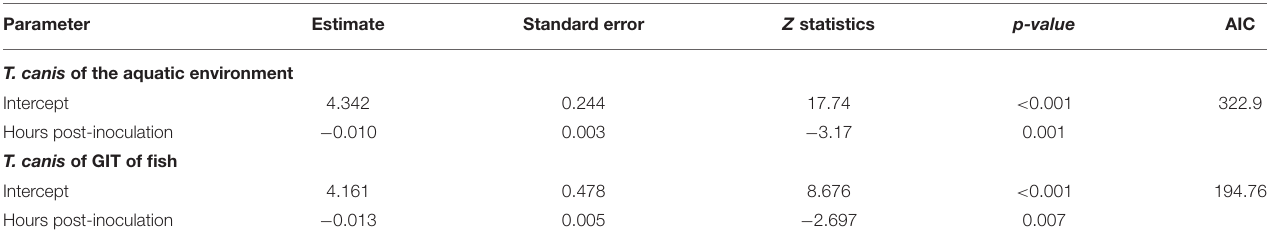
TABLE 2 | Negative binomial regression model to assessment T. canis eggs and larvae recovered of the aquatic environment and in the gastrointestinal tracts (GIT) of Nile tilapia experimentally inoculated with T. canis embryonated eggs, overtime.